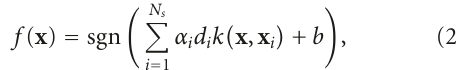
for a soft-margin SVM classifier is